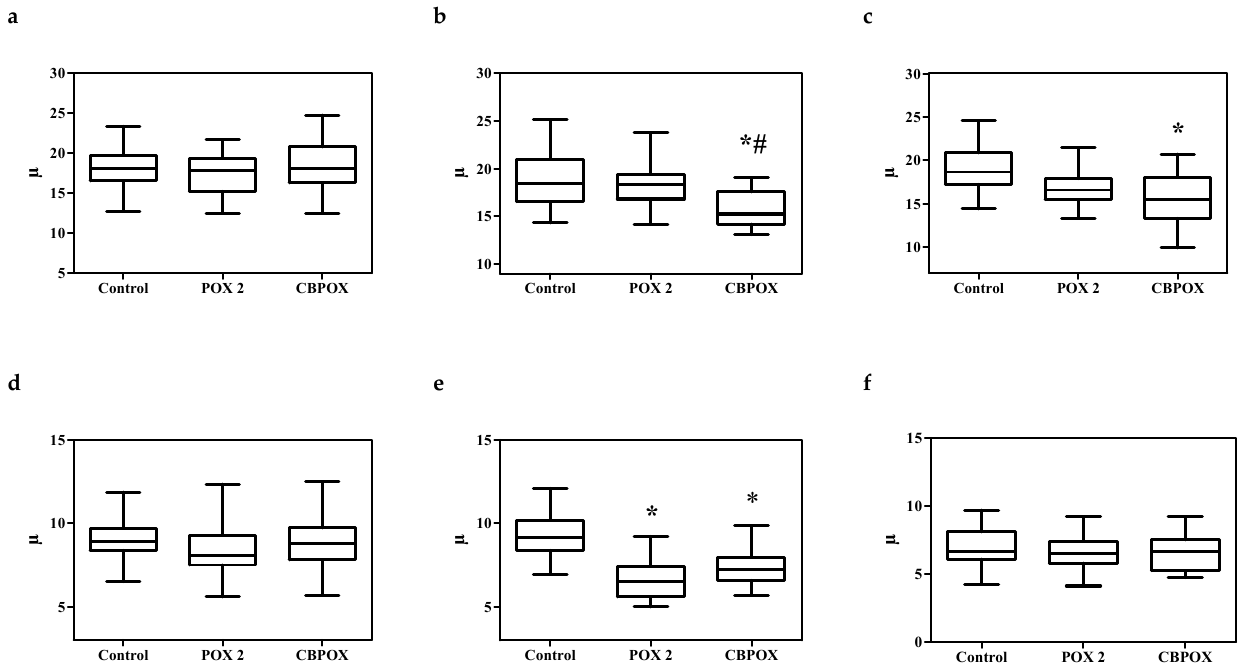
Figure 5. A ( a – c ). Diameter of distal convoluted tubules (DCT), µ m: ( a ) 1 day, ( b ) 3 days, and ( c ) 7 days after exposure to POX. B ( d – f ). Lumen diameter of distal convoluted tubules (DCT), µ m: ( d ) 1 day, ( e ) 3 days, and ( f ) 7 days after the poisoning. * p ≤ 0.01 compared to the control group; # p ≤ 0.01 between POX2x and CBPOX groups.